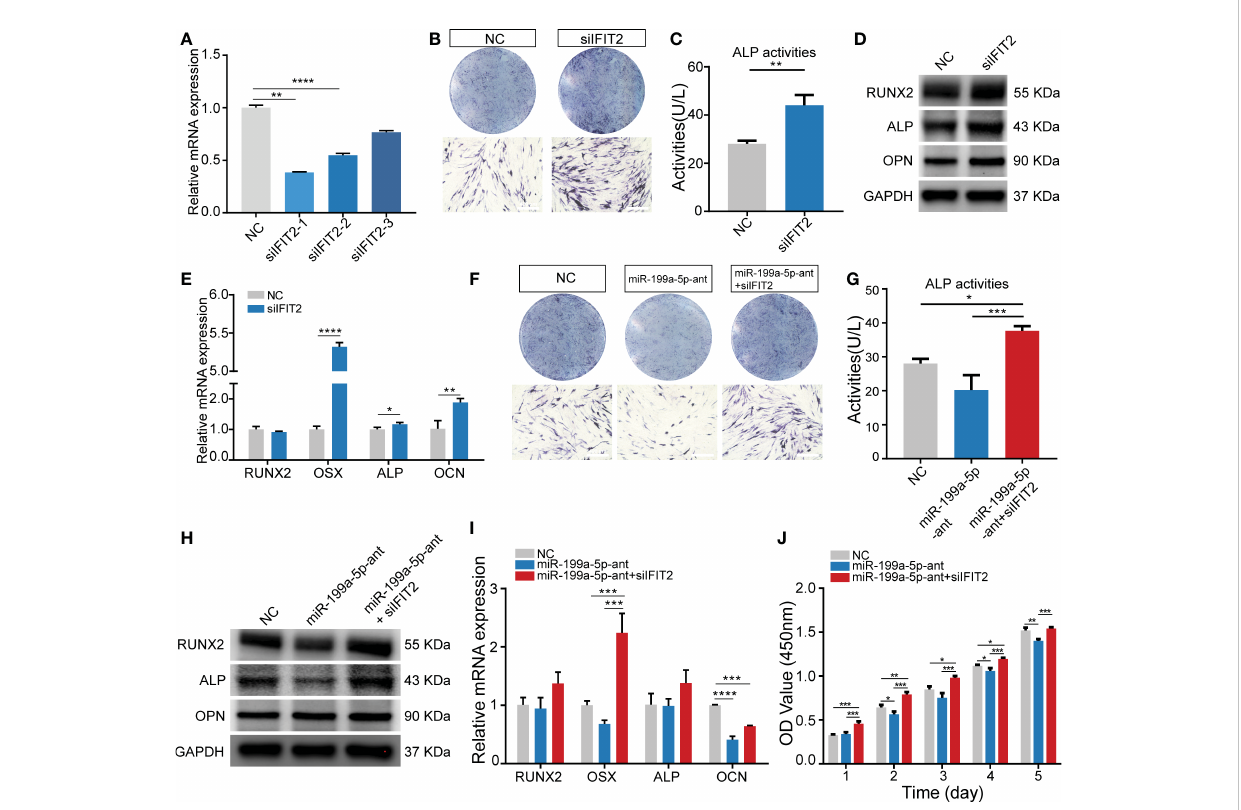
FIGURE 5 Knockdown of IFIT2 can reverse the effect of endogenous miR-199a-5p reduction on osteogenesis. (A) The knockdown ef fi ciency of the three pairs of IFIT2 siRNAs. (B) ALP staining after 3 days of osteogenic induction (scale bar = 400 m m). (C) ALP activity assays. (D) The protein expression levels of RUNX2, ALP, and OPN. (E) The relative mRNA expression level of osteogenic marker genes RUNX2 , OSX , ALP , and OCN . (F) ALP staining after 3 days of osteogenic induction (scale bar = 400 m m). (G) ALP activity assay. (H) The protein expression levels of RUNX2, ALP, and OPN. (I) The relative mRNA expression level of osteogenic marker genes RUNX2 , OSX , ALP , and OCN . (J) The CCK-8 assay. The data were shown as mean ± SD. * p < 0.05, ** p < 0.01, *** p < 0.001, and **** p <